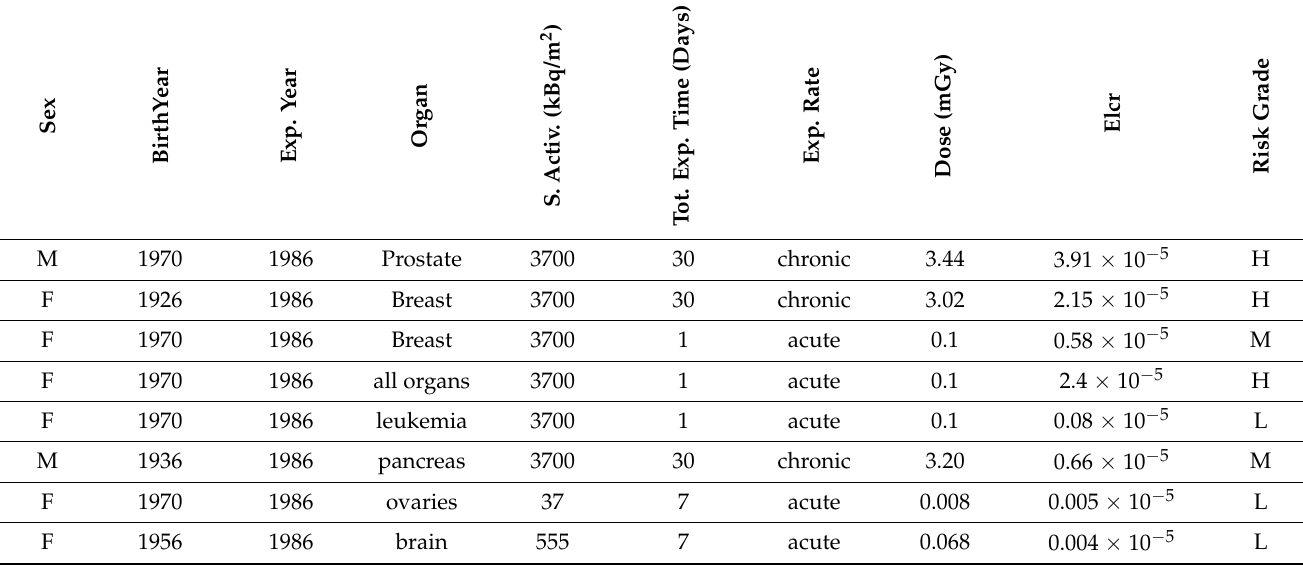
Table 1. Data of hypothetical individuals exposed to the radiation from Chernobyl nuclear accident [sex (male, female), birth year, exposure year, exposed organ, surface activity (kBq/m 2 ), total exposure time (days), exposure rate, dose (mGy)] for the assessment of ELCR and risk grade (High, Medium and